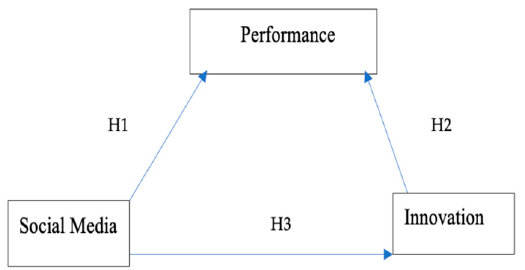
Figure 1. Conceptual framework.